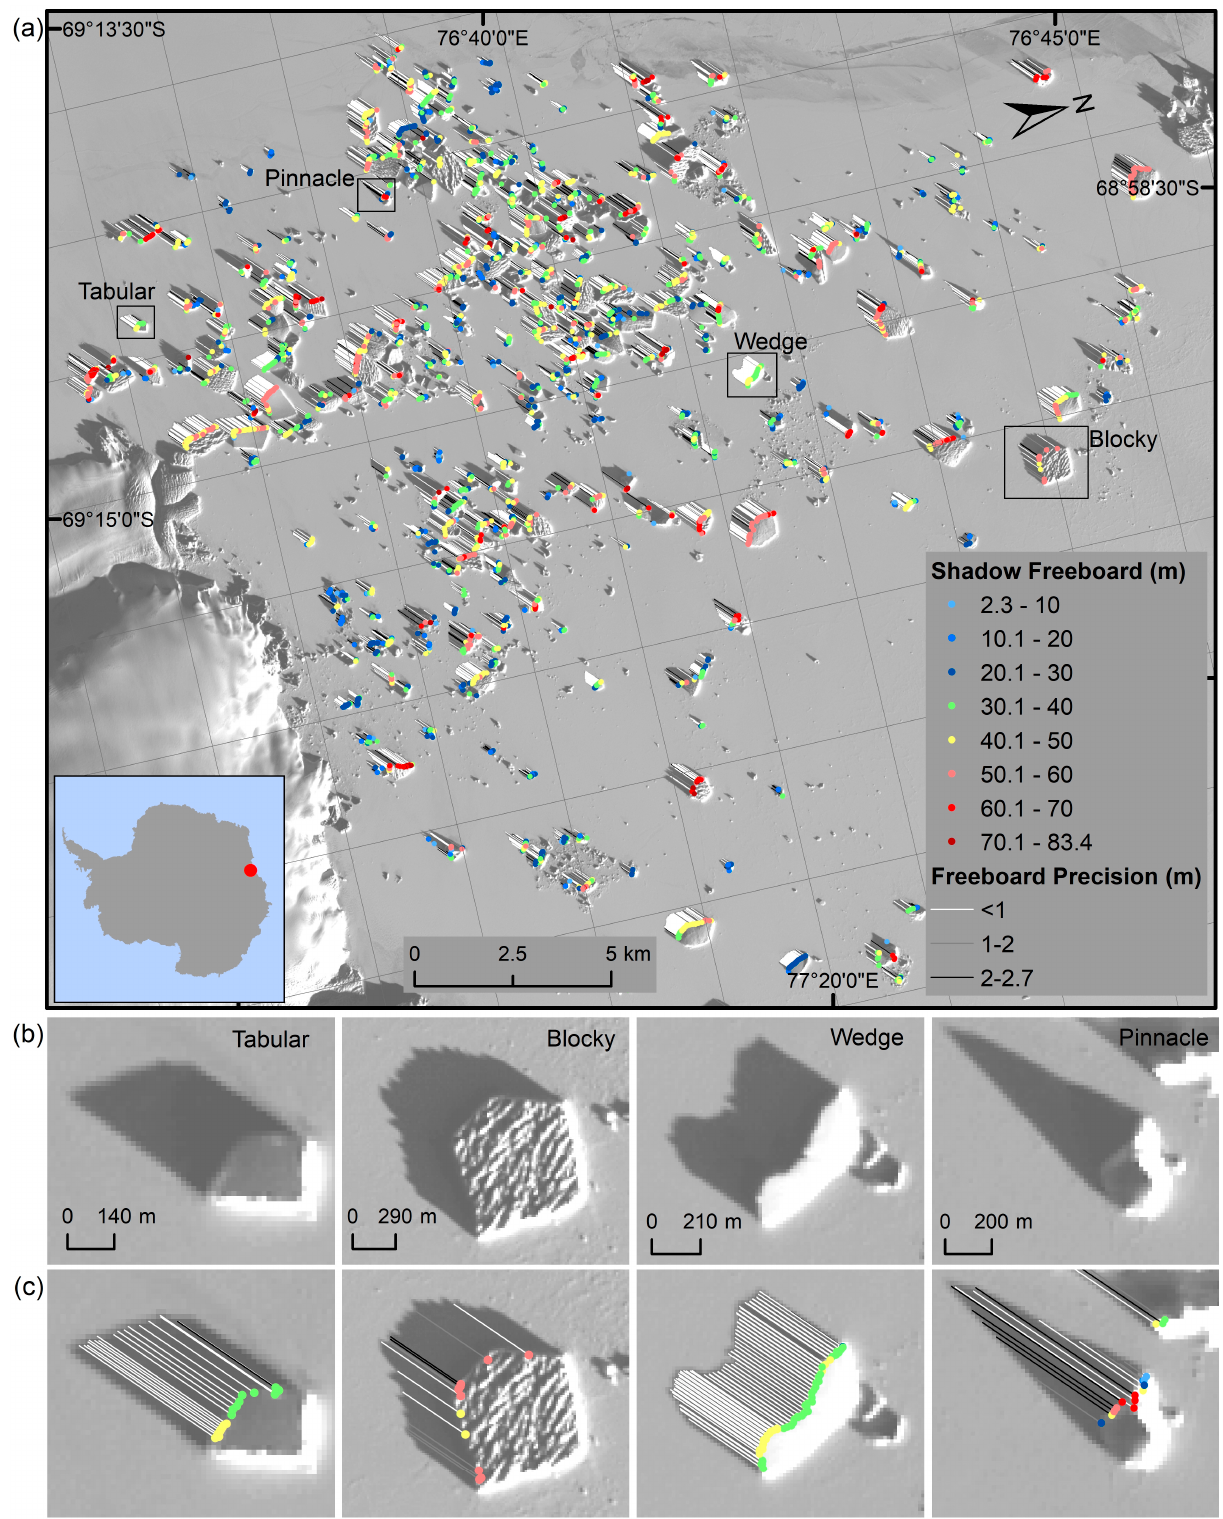
Figure 3. ( a ) Freeboards of H 8/29 with different precision in the case study area. The colored points show the freeboards of the SFPs of the different magnitudes. The colored lines are the shadow length line vectors from the SFPs, and the different colors indicate different freeboard precision of the SFPs. ( b ) Landsat-8 panchromatic shadow images on 29 August 2016 of the tabular, blocky, wedge, and pinnacle icebergs. ( c ) Effective freeboards with the precision of the tabular, blocky, wedge, and pinnacle